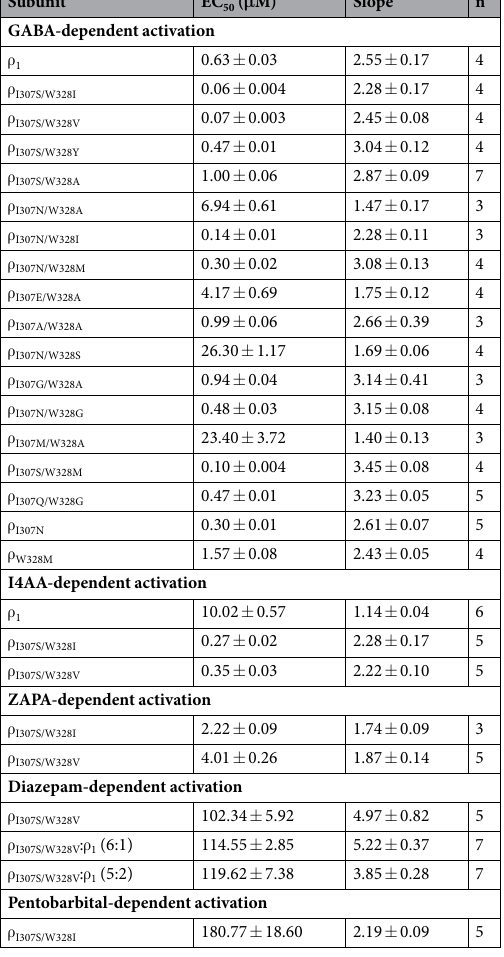
Table 1. Parameters determined from fitting the logistic equation to the data points of the GABA, I4AA, ZAPA, diazepam, and pentobarbital concentration-response relationships. All data are presented as the mean ± standard error